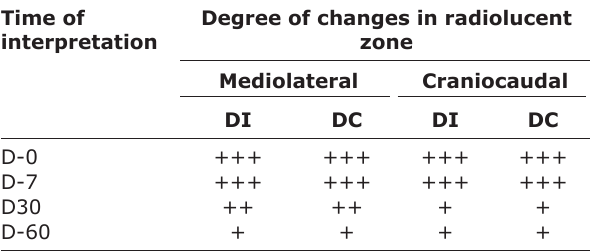
craniocaudal radiographic images.